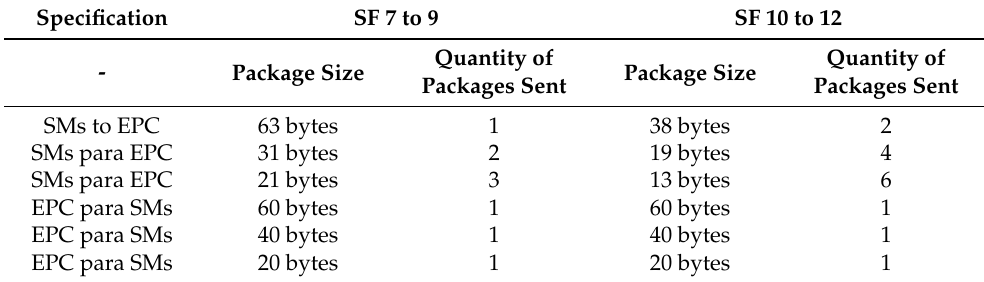
Table 3. Package size